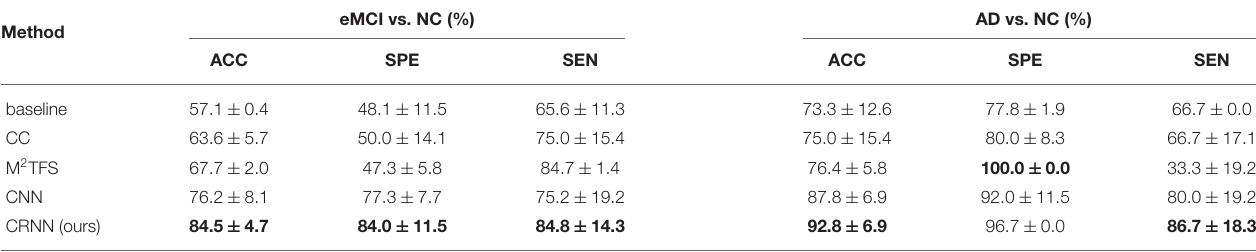
TABLE 2 | Performance of five methods in two binary classification tasks, i.e., eMCI vs. NC and AD vs. NC classifications (Mean ± SD). Method